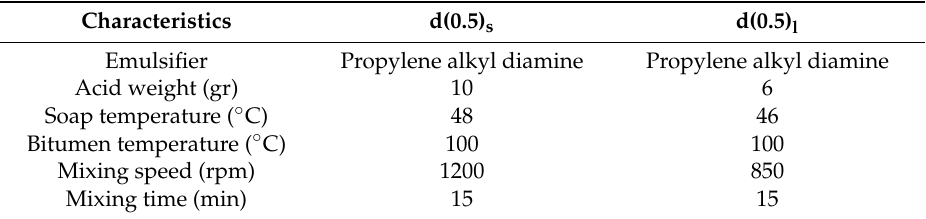
Table 2. Physicochemical characteristics to produce the different